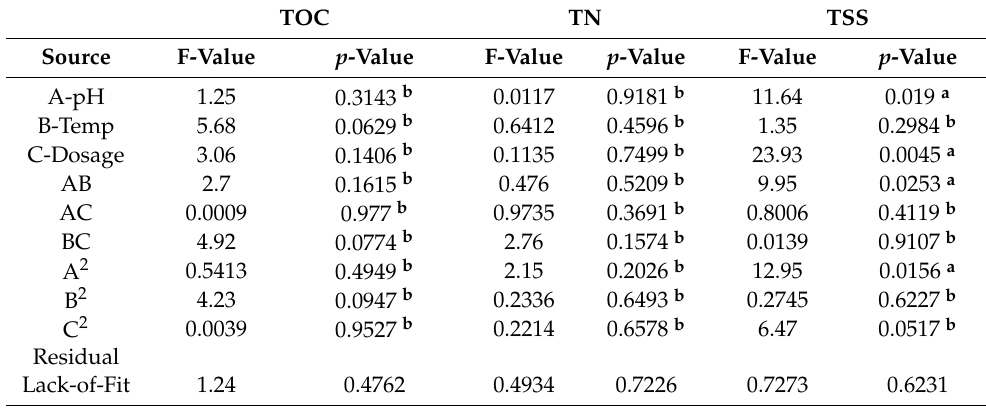
Table 4. Analysis of variance (ANOVA) data for PAC treatment of TOC, TN, and